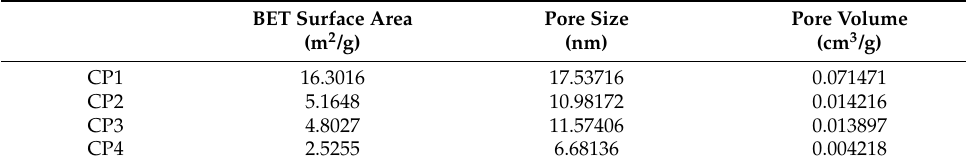
Table 1. BET surface area.